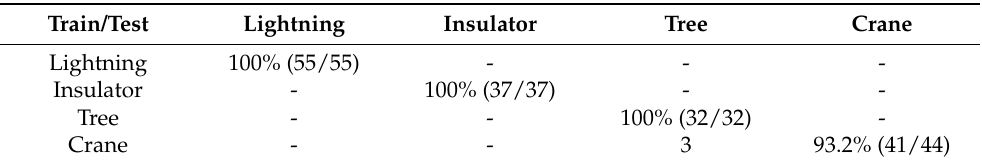
Table 13. Accuracy of the created decision tree w.r.t. interaction-curvature predictor selection on test set data for 80% training and 20% testing.